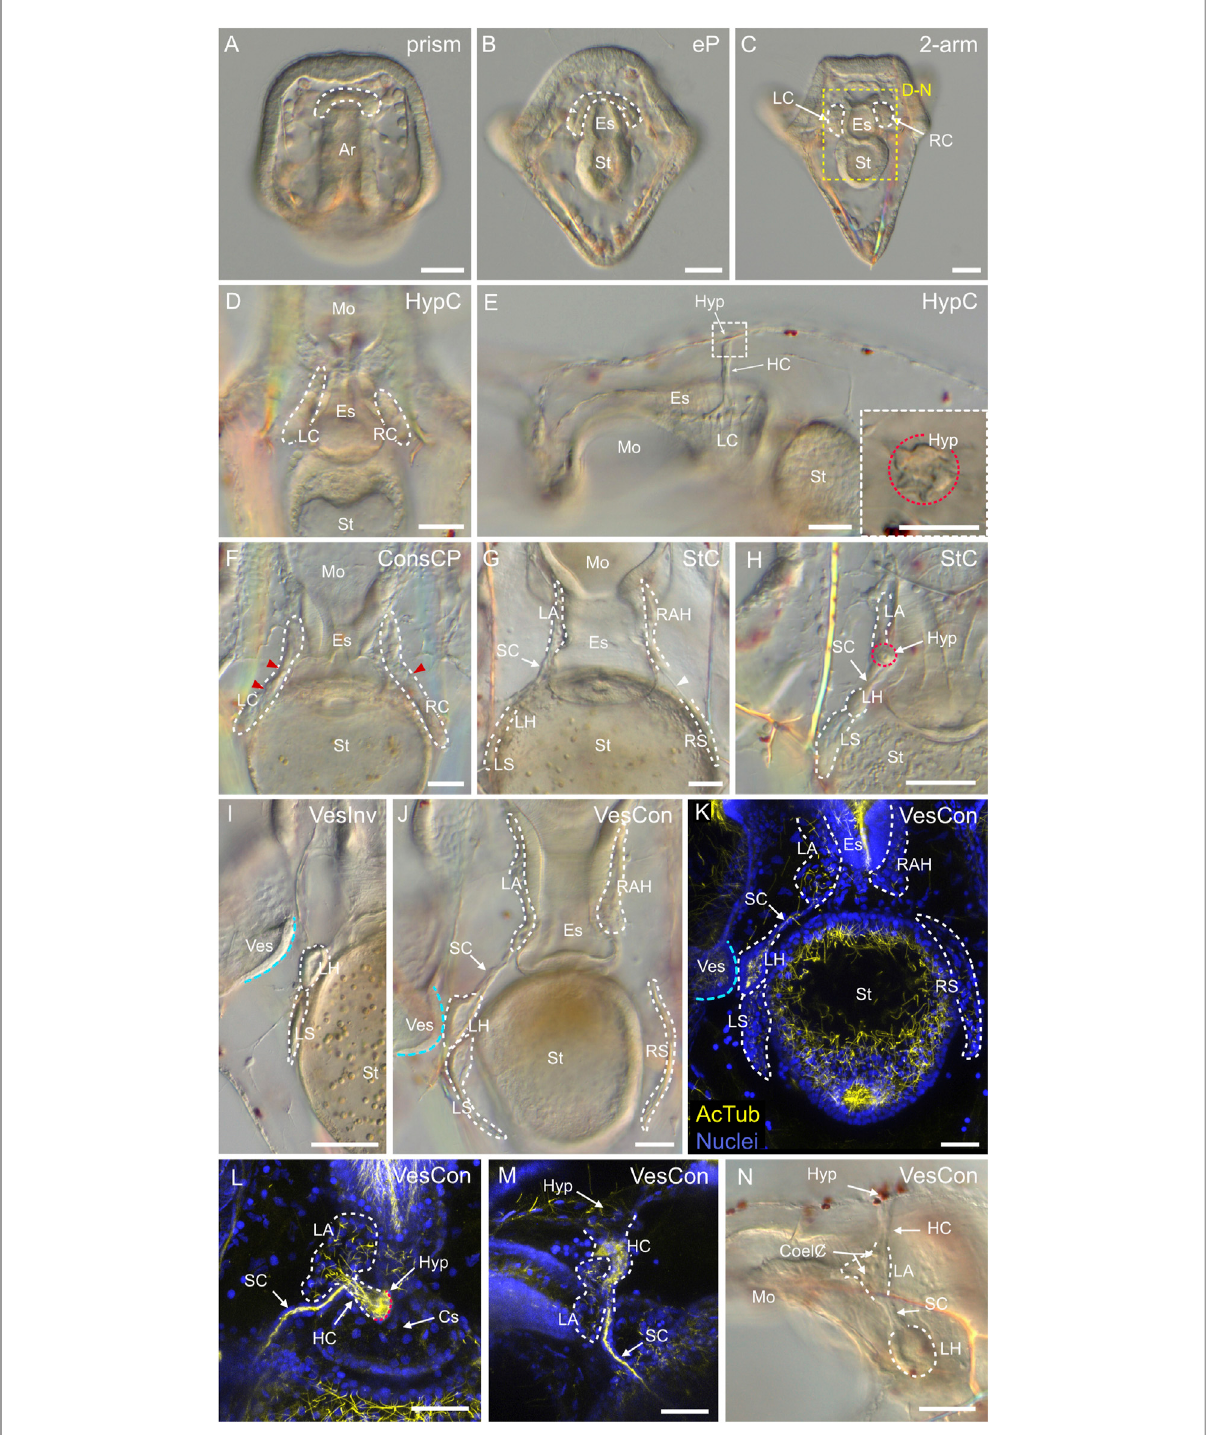
FIGURE 11 Coelomogenesisin Paracentrotuslividus during theembryonicand larvalperiods.Developmentalstages are asfollows: (A) prismstage(prism); (B) early-pluteus stage (eP); (C) 2-arm pluteus stage (2-arm); (D,E) hydroporic canal stage (HypC); (F) constricted coelomic pouch stage (ConsCP); (G,H) stonecanalstage(StC); (I) vestibuleinvaginatedstage(VesInv); (J – N) vestibulecontactstage(VesCon).In (A – J,N) ,imageswereacquiredusing bright- fi eld light microscopy. In (K – M) , images are maximum intensity projections of confocal z-stacks of larvae co-labeled for acetylated α - tubulin (cilia;yellow) and DNA(nuclei; blue),and theycorrespondto projectionsof theentire specimen. In (A) , theembryo isin ventral view,with the animal poleup.In (B – D,F – L) , larvaeare inanteriorview,with theventralsideup.In( (E) inset, (M,N) ),larvae areinleftview,with theventralsidetothe